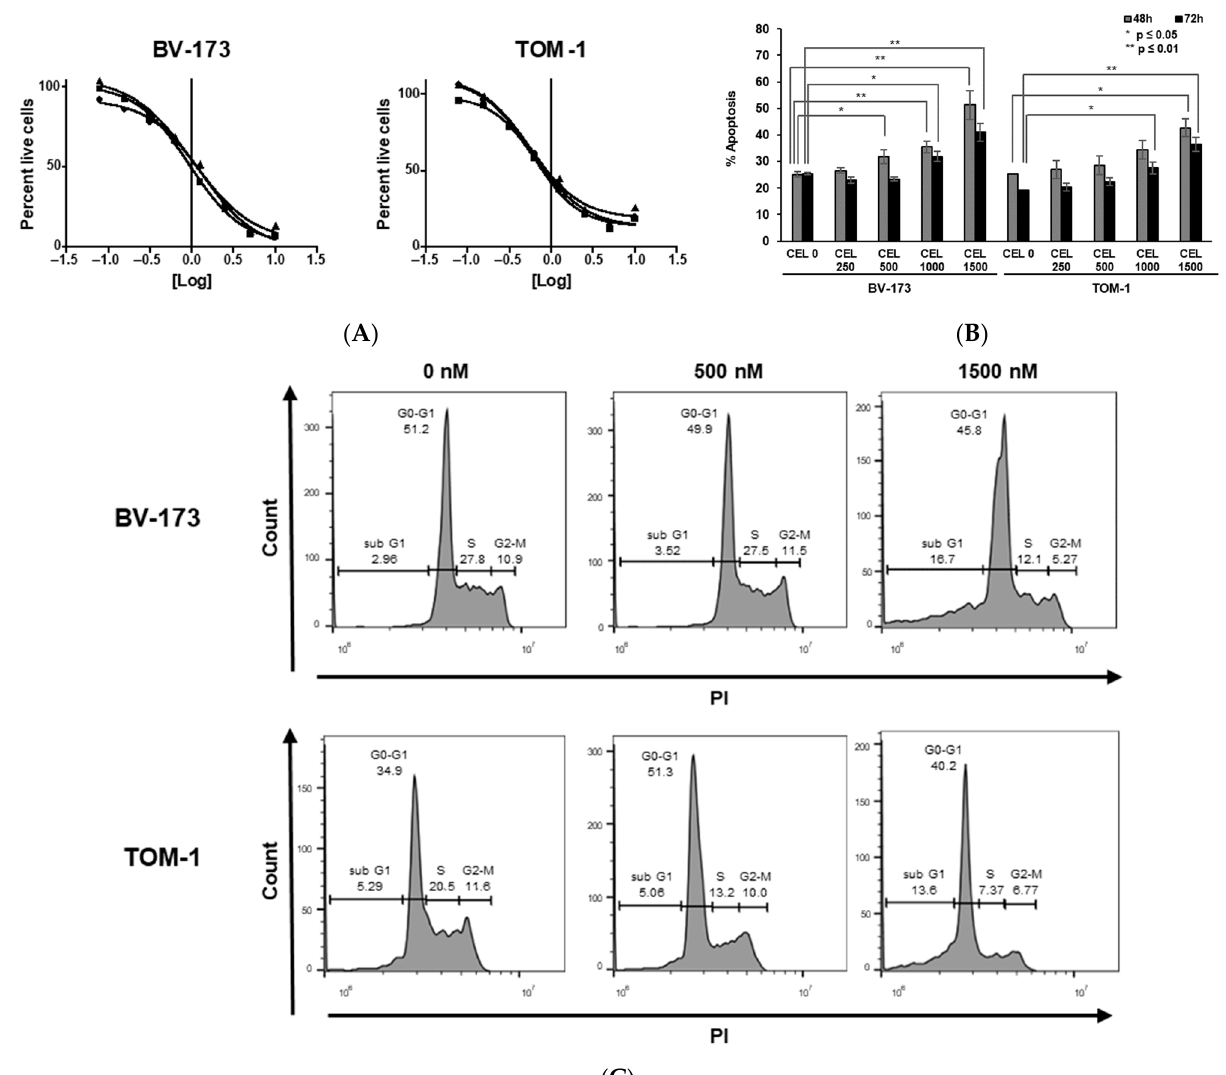
Figure 1. In vitro effect of LIMKi on viability, apoptosis, and cell cycle in BCR::ABL1 + ALL cell lines. IC50 was determined by MTS assay after exposure to increasing doses of CEL_Amide (78–10,000 nM) in indicated cell lines at 72 h. Results are shown as mean ± SEM from triplicate ( n = 3) ( A ). Apoptosis of BV-173 and TOM-1 cell lines after 48 and 72 h treatment with different doses of CEL_Amide (250–1500 nM). Apoptotic cells were defined as Annexin V+ with or without PI uptake. Results are shown as mean ± SEM from duplicate ( n = 3) ( B ). Cell cycle modifications at 48 h induced by increasing CEL_Amide doses (500–1500 nM) in BV-173 and TOM-1 cell lines ( n = 3) ( C ).